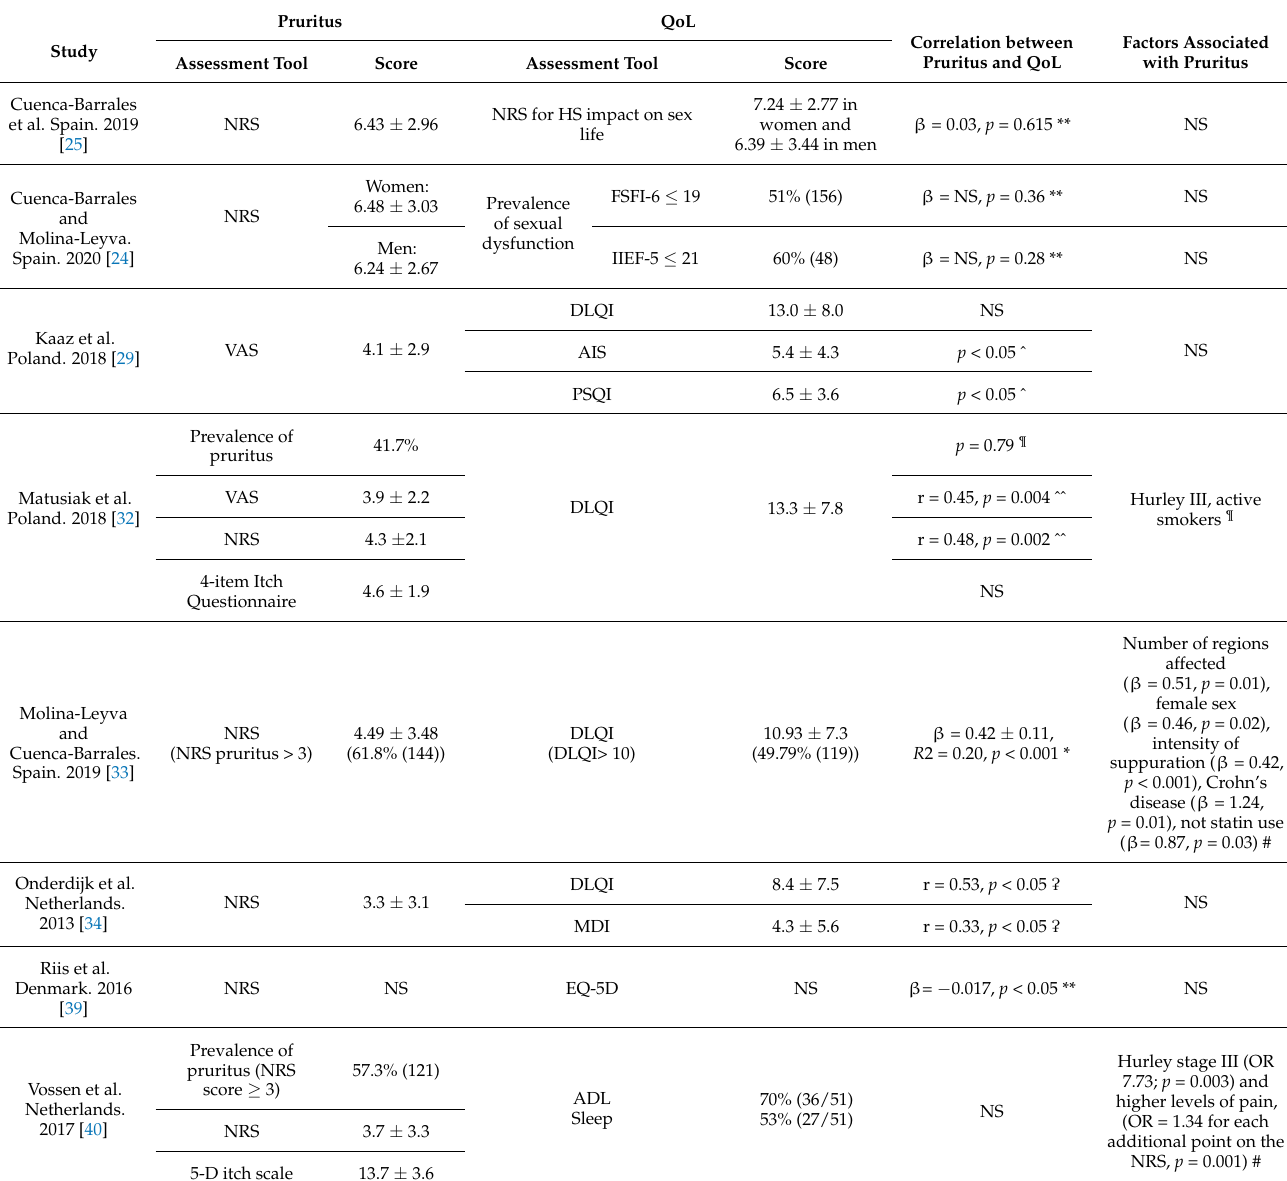
Table 3. Studies regarding pruritus impact on